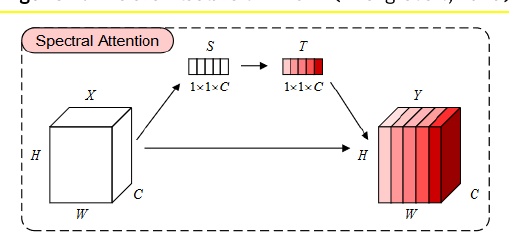
Table 1. Category and size of samples in adjusted